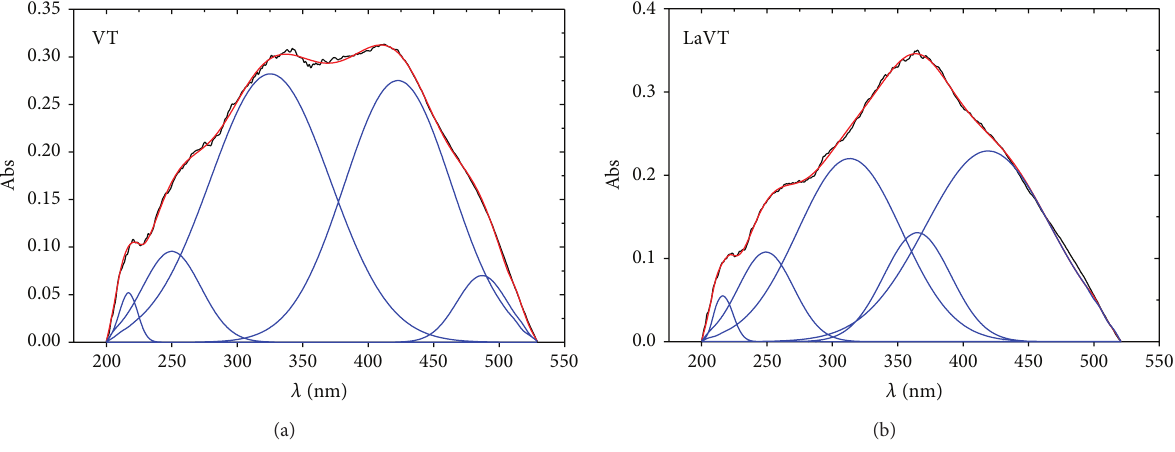
Figure 2: UV-Vis spectra of VT (a) and LaVT (b).